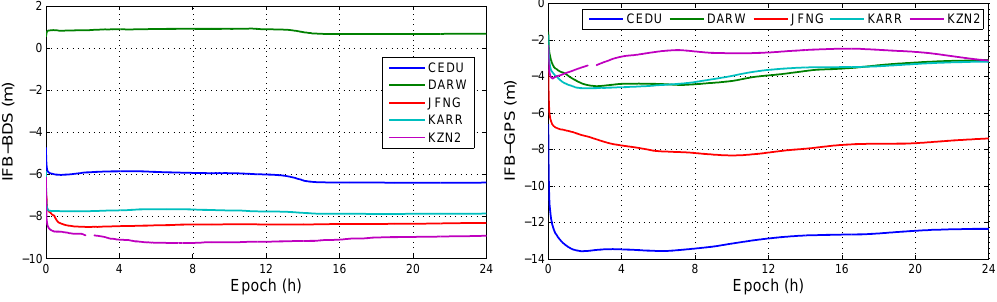
Figure 8. IFB at different stations in DOY 100,